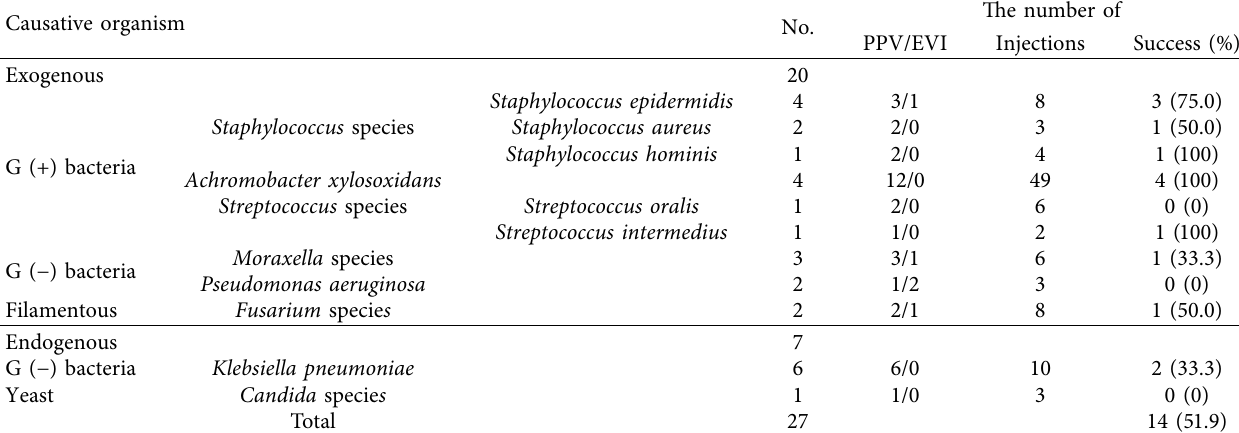
Table 3: Identified organisms and treatment results in exogenous and endogenous endophthalmitis. Causative